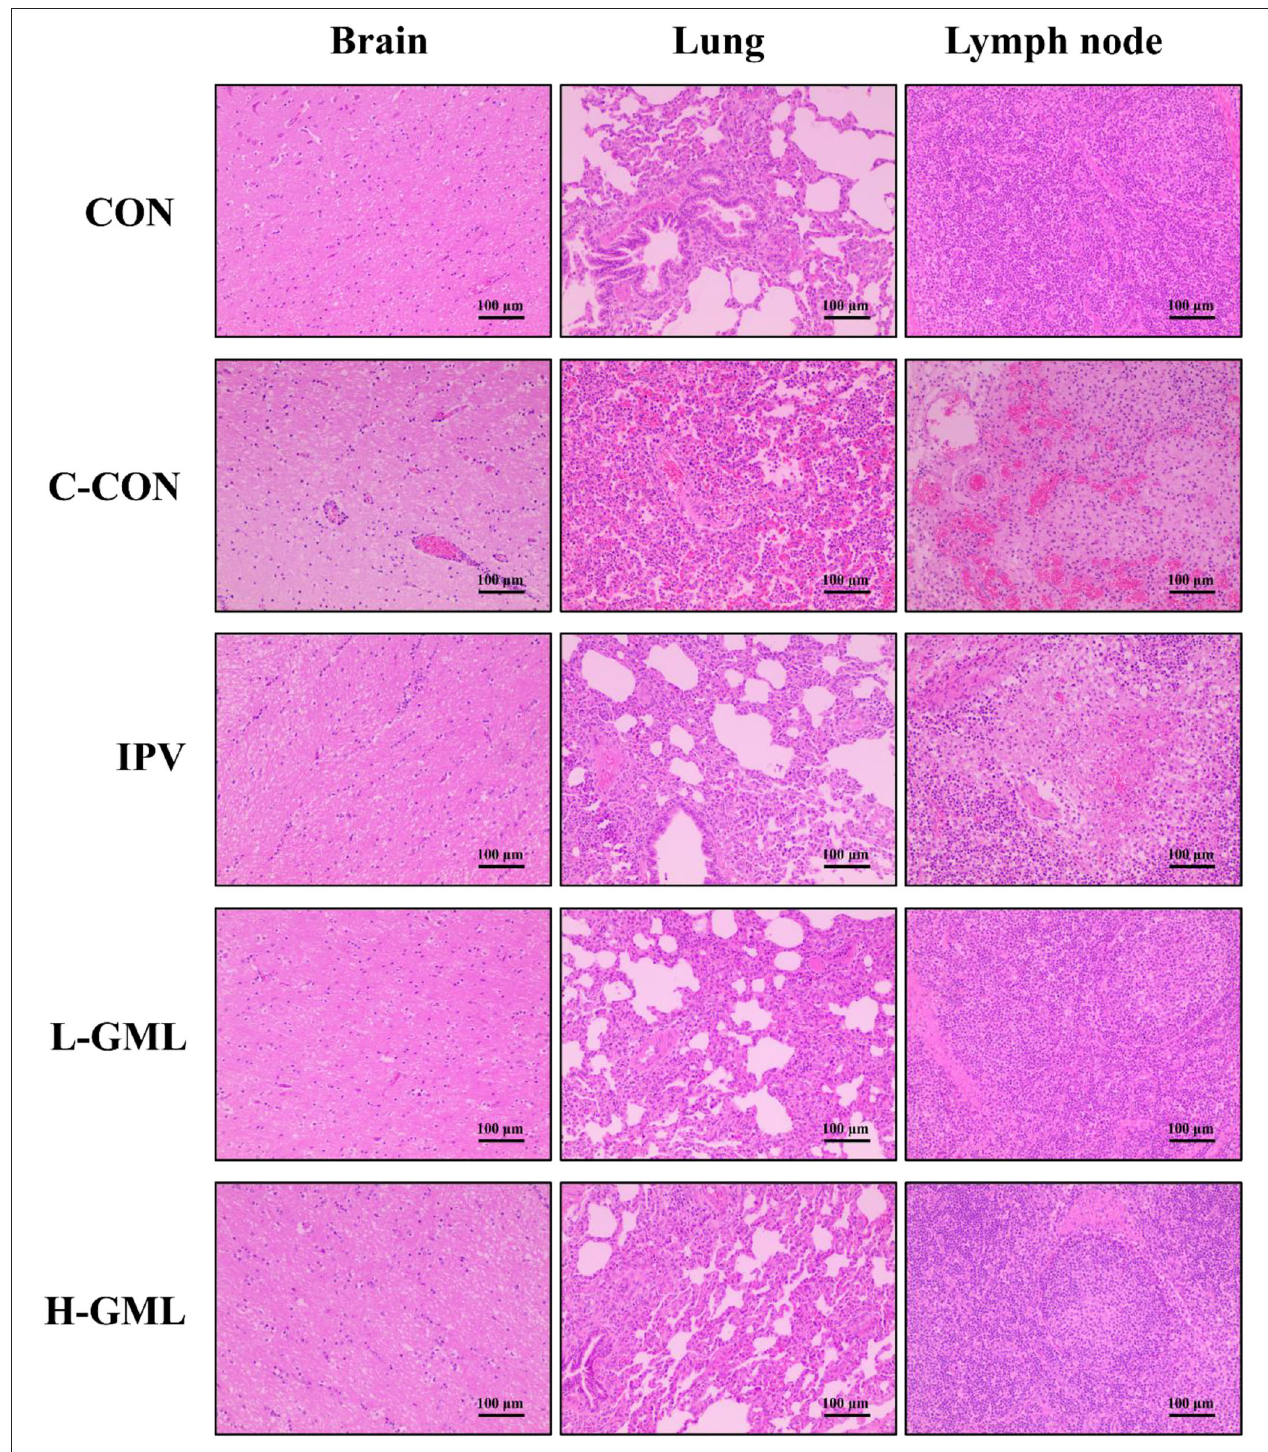
FIGURE 5 | Histopathological observations in the brain, lung, and superficial inguinal lymph nodes of experimental pigs.